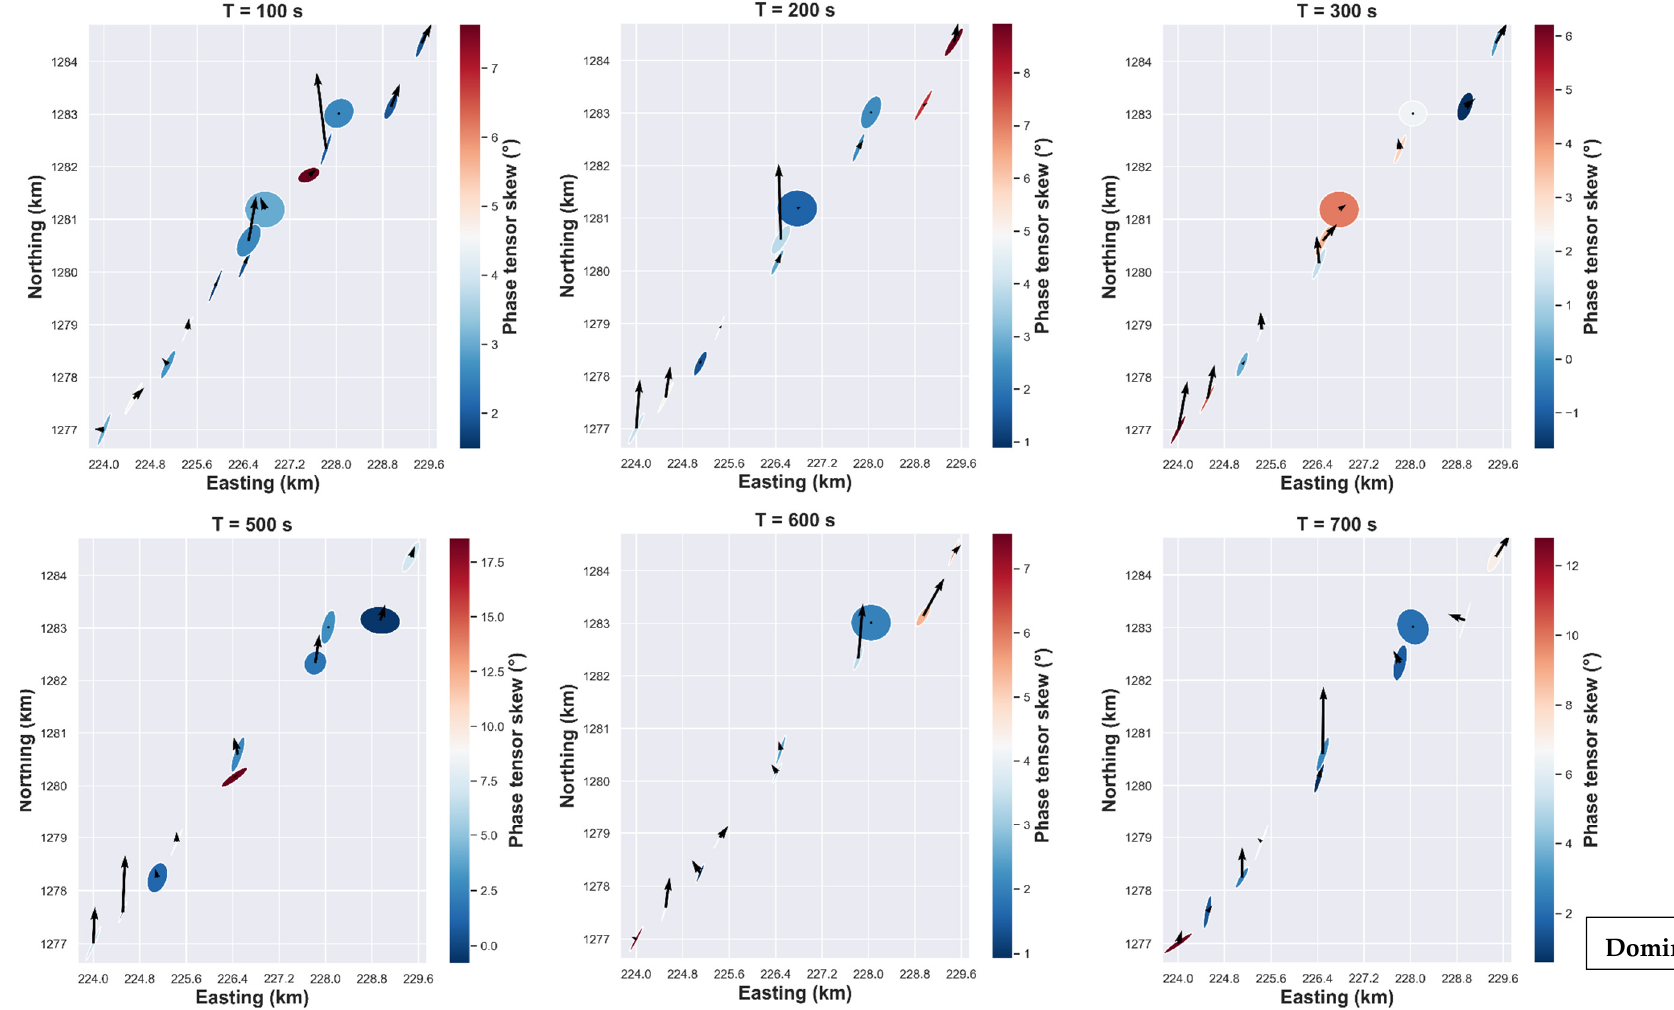
Figure 5. Real induction vectors with phase tensor ellipse.